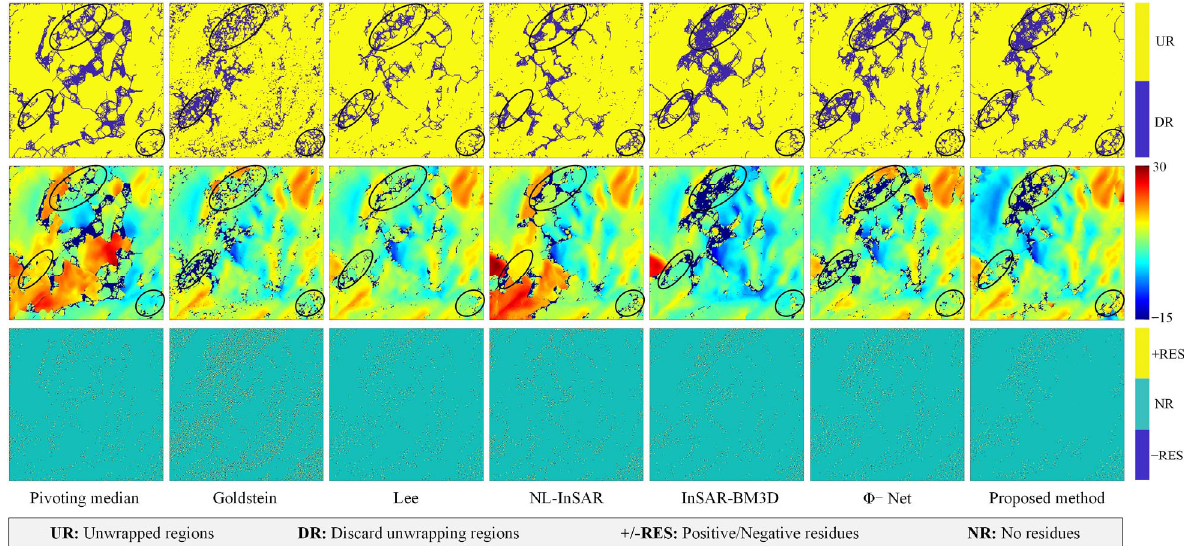
Figure 11. Phase unwrapping results for the case of L’Aquila, that the first row is unwrappable area, the second row is unwrapping result. the third row is residues distribution.